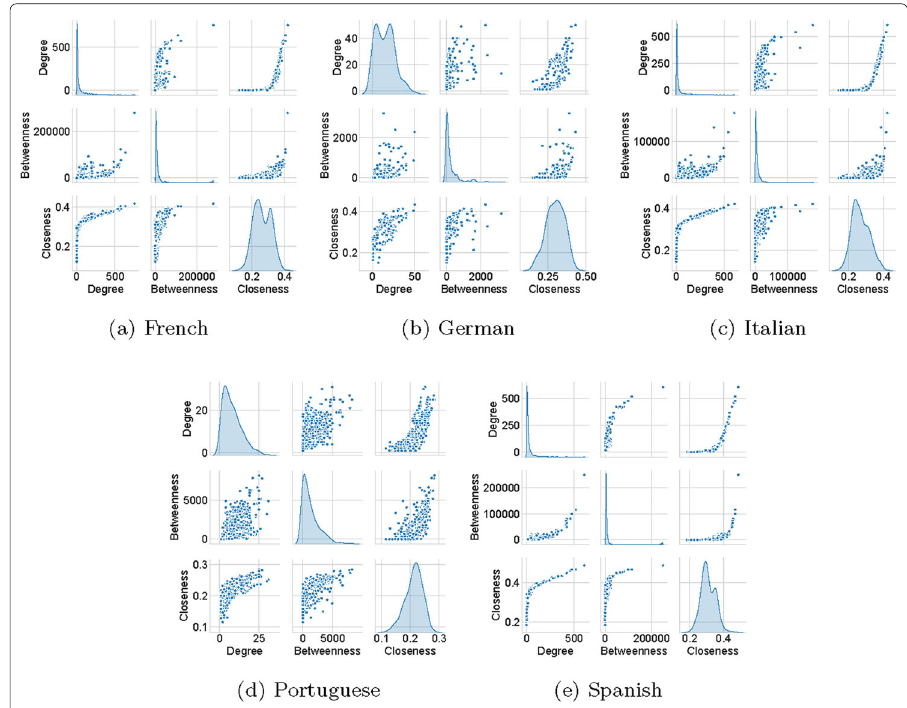
Fig. 11 Centrality Metric Correlations. This figure illustrates the correlations between the three centrality metrics, respectively for each language. For all metrics and languages, we observe a strong positive correlation, suggesting that words are similarly central across